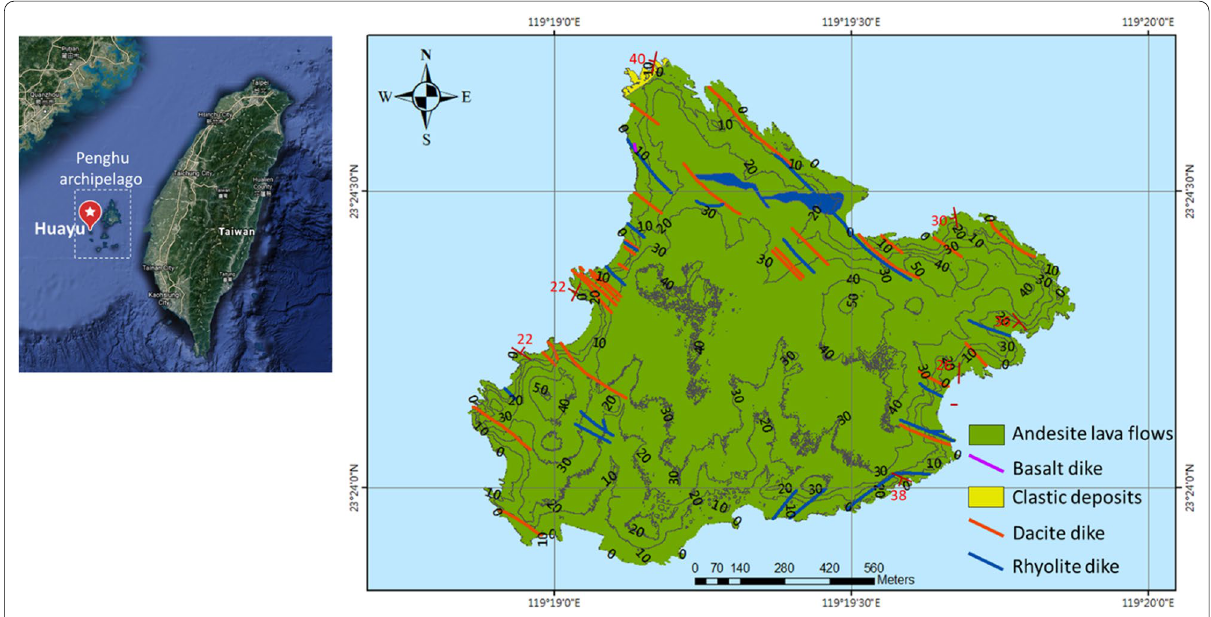
Fig. 2 The location and the geologic map of